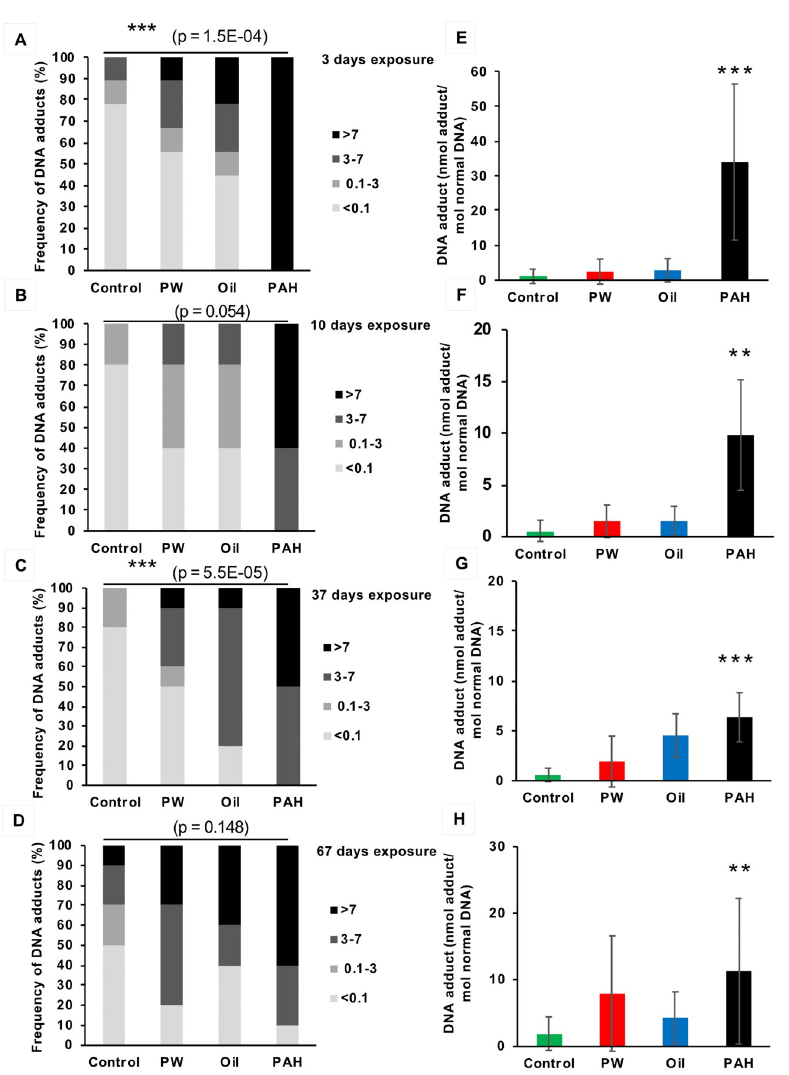
Fig 3. DNA adducts in the liver of fish from the different treatments groups after 3 days (one dose) (A and E, n = 9), 10 days (B and F, n = 5), 37 days (C and G, n = 10) and 67 days (D and H, n = 10) of oral exposure to three exposure feeds; produced water (PW), oil fraction (oil) and heavy PAH mixture and a clean control feed. A-D show the frequency (%) of DNA-adduct divided into four intervals (below detection limit; < 0.1 nmol DNA adduct/ mol normal DNA, 0.1–3 nmol DNA adduct/mol normal DNA, 3–7 nmol DNA adduct/mol normal DNA, > 7 nmol DNA adduct/mol normal DNA. Asterisks indicate statistical difference in the relative distribution between the treatment groups (Fisher Exact Contingency Table analysis). P < 0.001 = ��� . E-H show the average amount of DNA adducts ( ± SD). Asterisks indicate statistical difference to the control fish (Kruskal-Wallis Test). P < 0.01 = ��